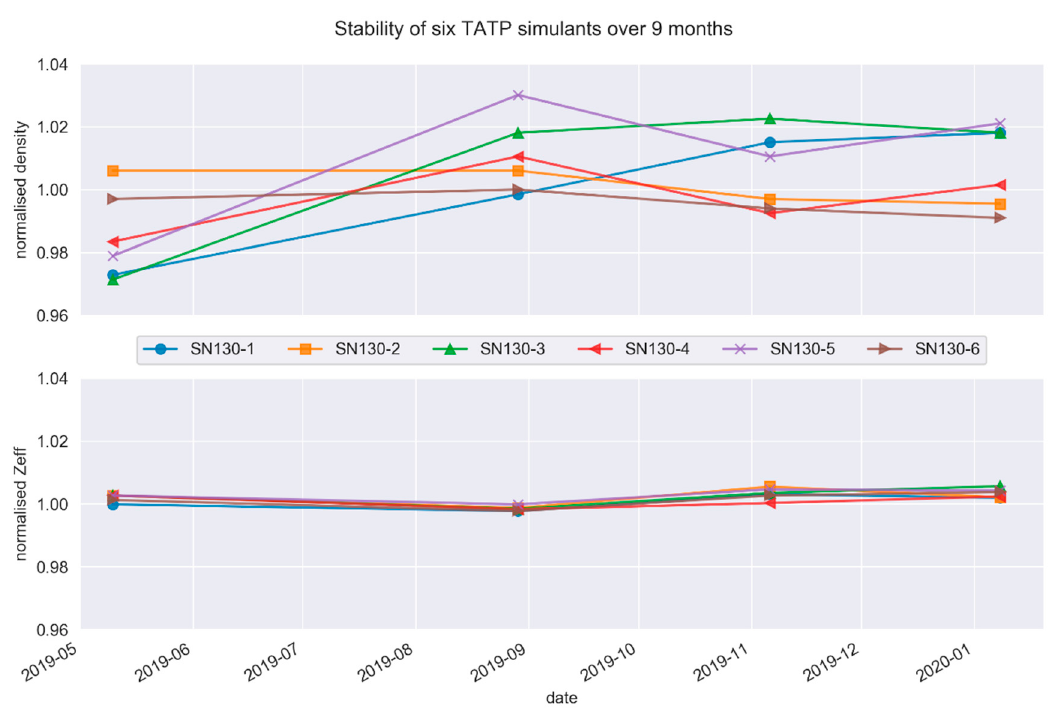
Figure 4. Stability testing data for six simulants for bulk density (top) and effective atomic number, Zeff (bottom) recorded at room temperature (21 °C) over a period of nine months.